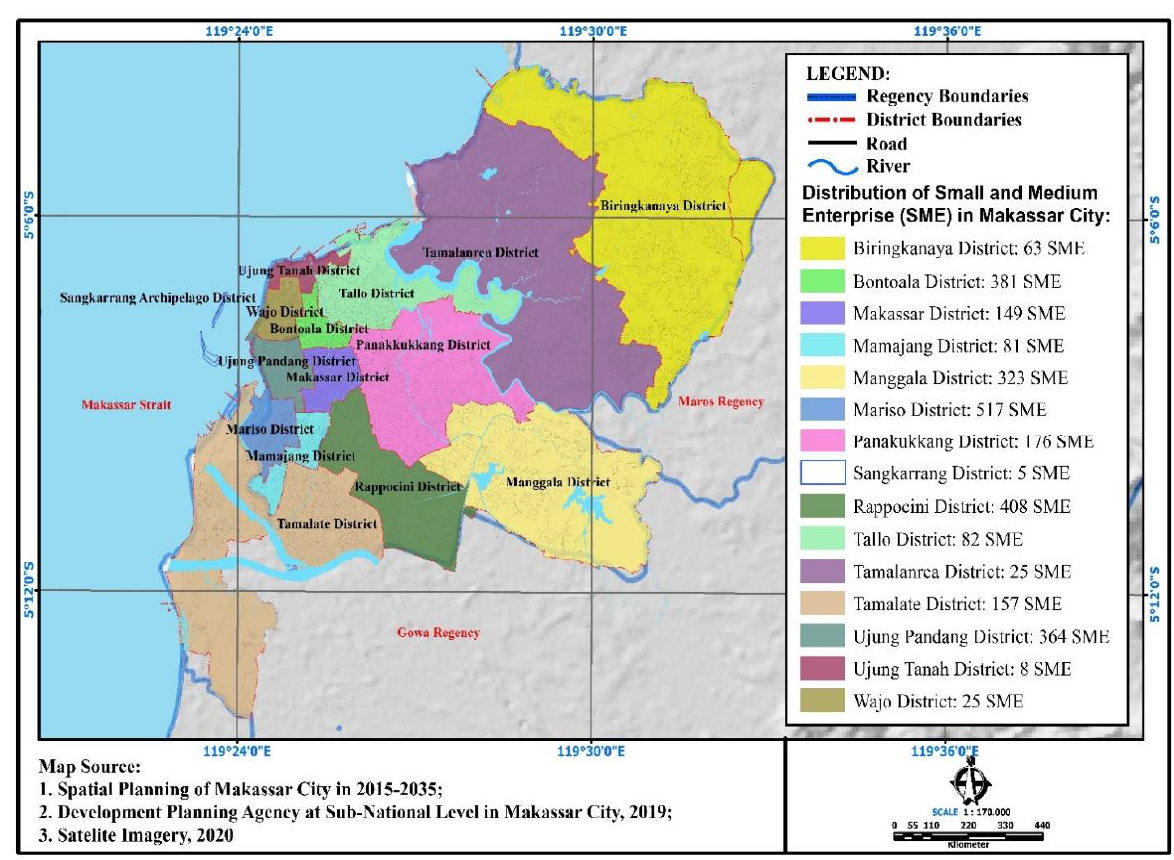
Figure 2. Small and medium enterprises (SMEs) in Makassar City as study objects. Source: author’s elaboration and development planning agency at sub-national level in Makassar City.